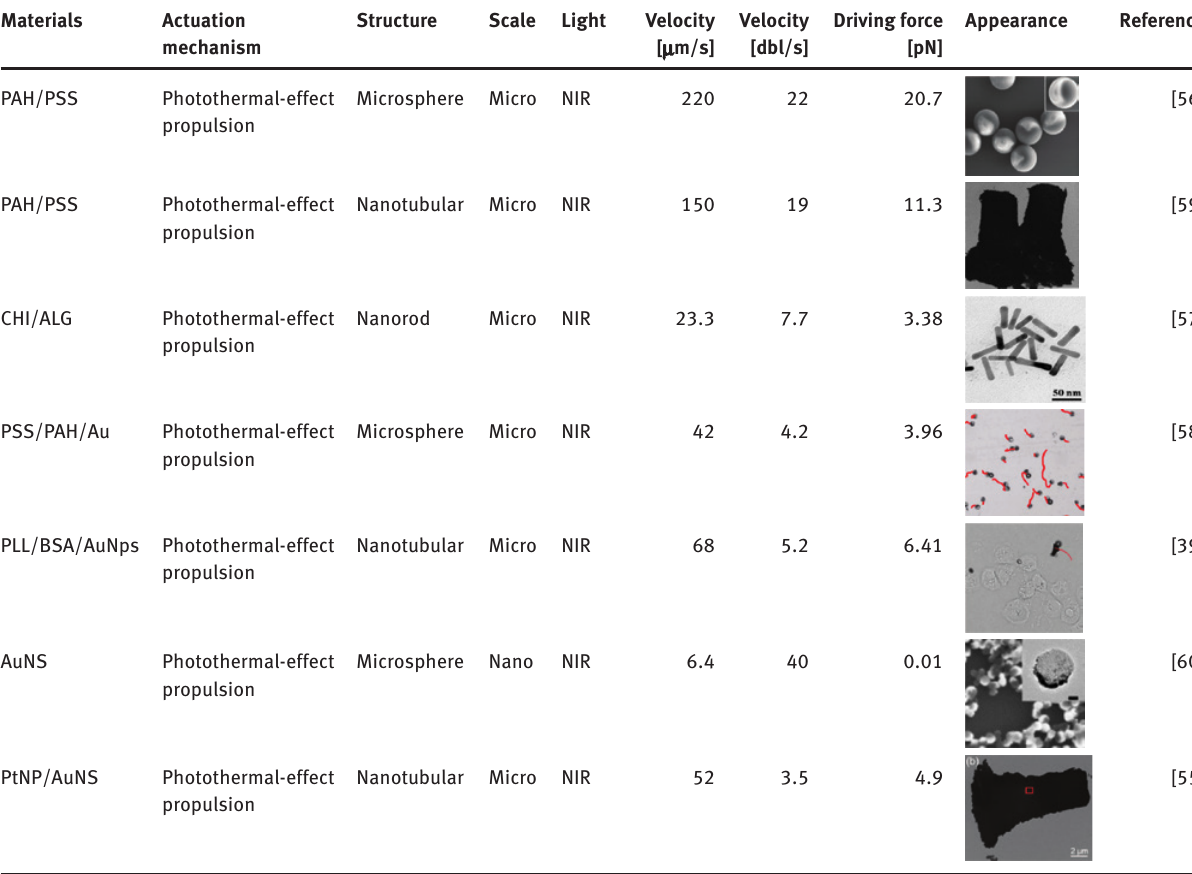
Table 3: Comparison of motion velocity and estimated driving force for light-driven micro/nanomotors through photothermal-effect